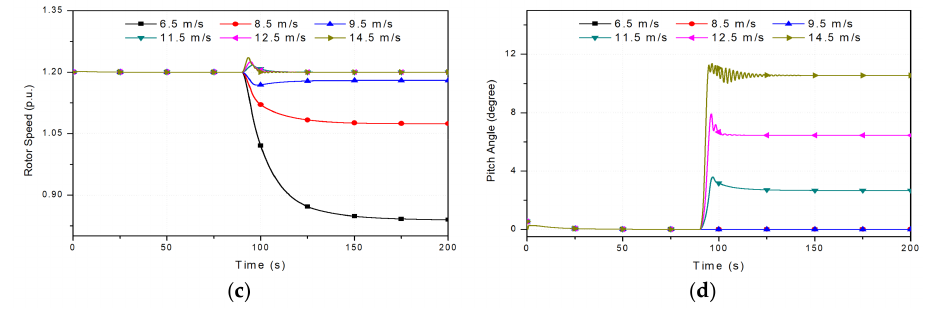
Figure 18. Simulation results with speed reference control: ( a ) Wind speed; ( b ) Output power; ( c ) Rotor speed; ( d ) Pitch angle.